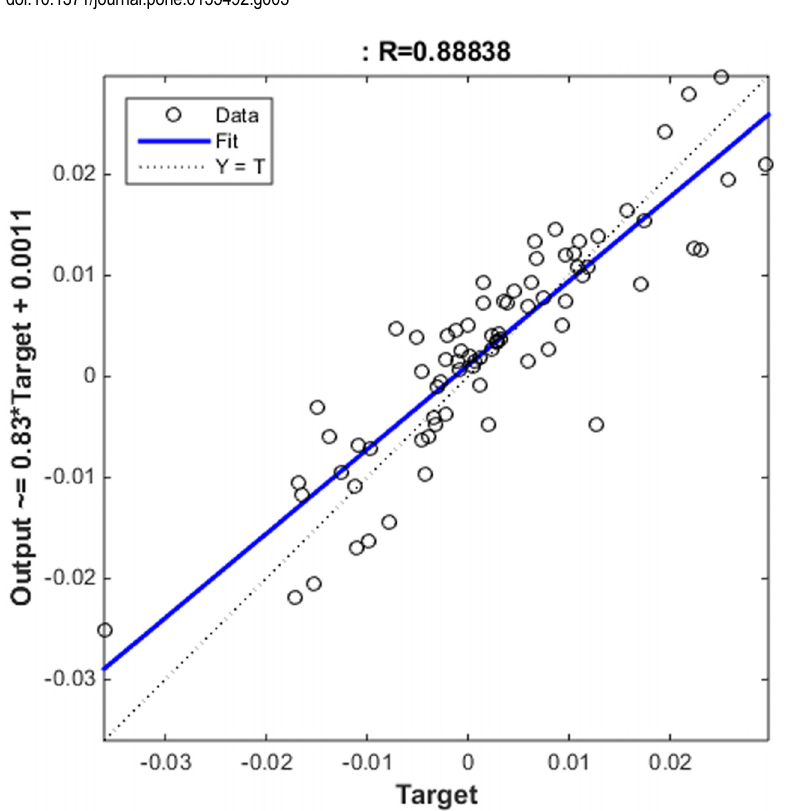
Fig 4. The plot of actual residual values and NARNN model fitted values.